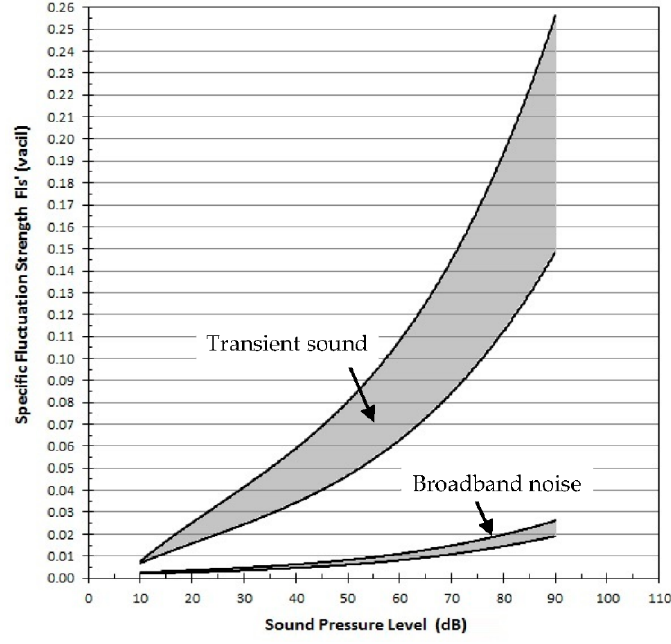
Figure 2. Loudness level ( L N ) as a function of sound pressure level for different sound signals including transient and steady state signals. The shaded area characterizes the region for the loudness level ( L N ). The straight line corresponds to the following relationship: sound pressure level = loudness level.